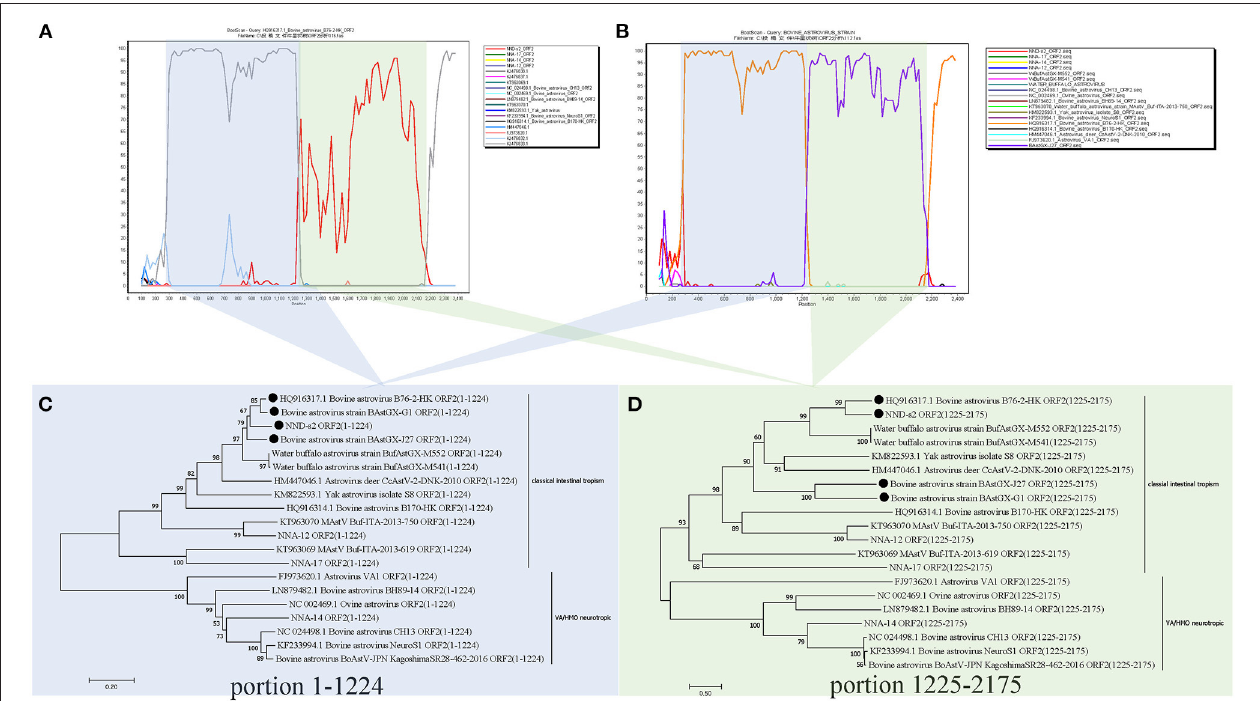
FIGURE 2 | BootScan recombination analysis based on the ORF2 gene of bovine Astrovirus B76-2-HK (A) and bovine Astrovirus GX1 (B) using the two-parameter (Kimura) distance and the neighbor-joining models were performed using 1,000 bootstrap replicates. The NJ phylogenetic trees of 1–1,224 nt (C) and 1,225–2,175 nt (D) of ORF2. In the clade of intestinal tropism AstVs, different topologies of phylogenetic trees are shown between portions 1–1,224 and 1,225–2,175. The construction was performed as described in the Results section. The black dots indicate the recombinant strains used in this study.